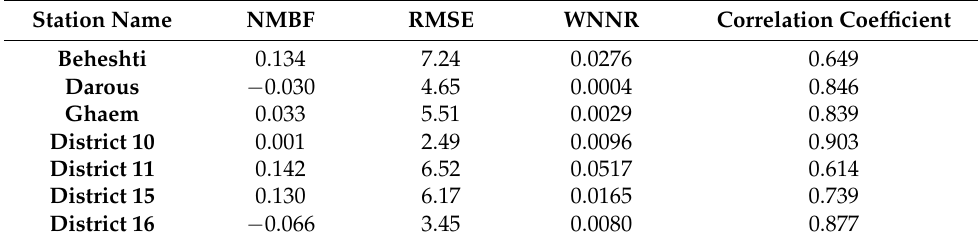
Table 2. The goodness-of-fit metrics at the validation-monitoring